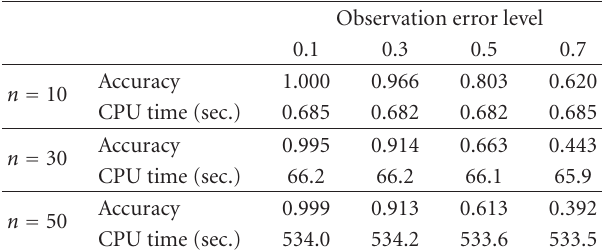
Table 2: Result on inference of WNT5A network by DPLSQ. Table 3: Result on inference of WNT5A network using ARACNE and GeneNet, where the accuracy is shown for each